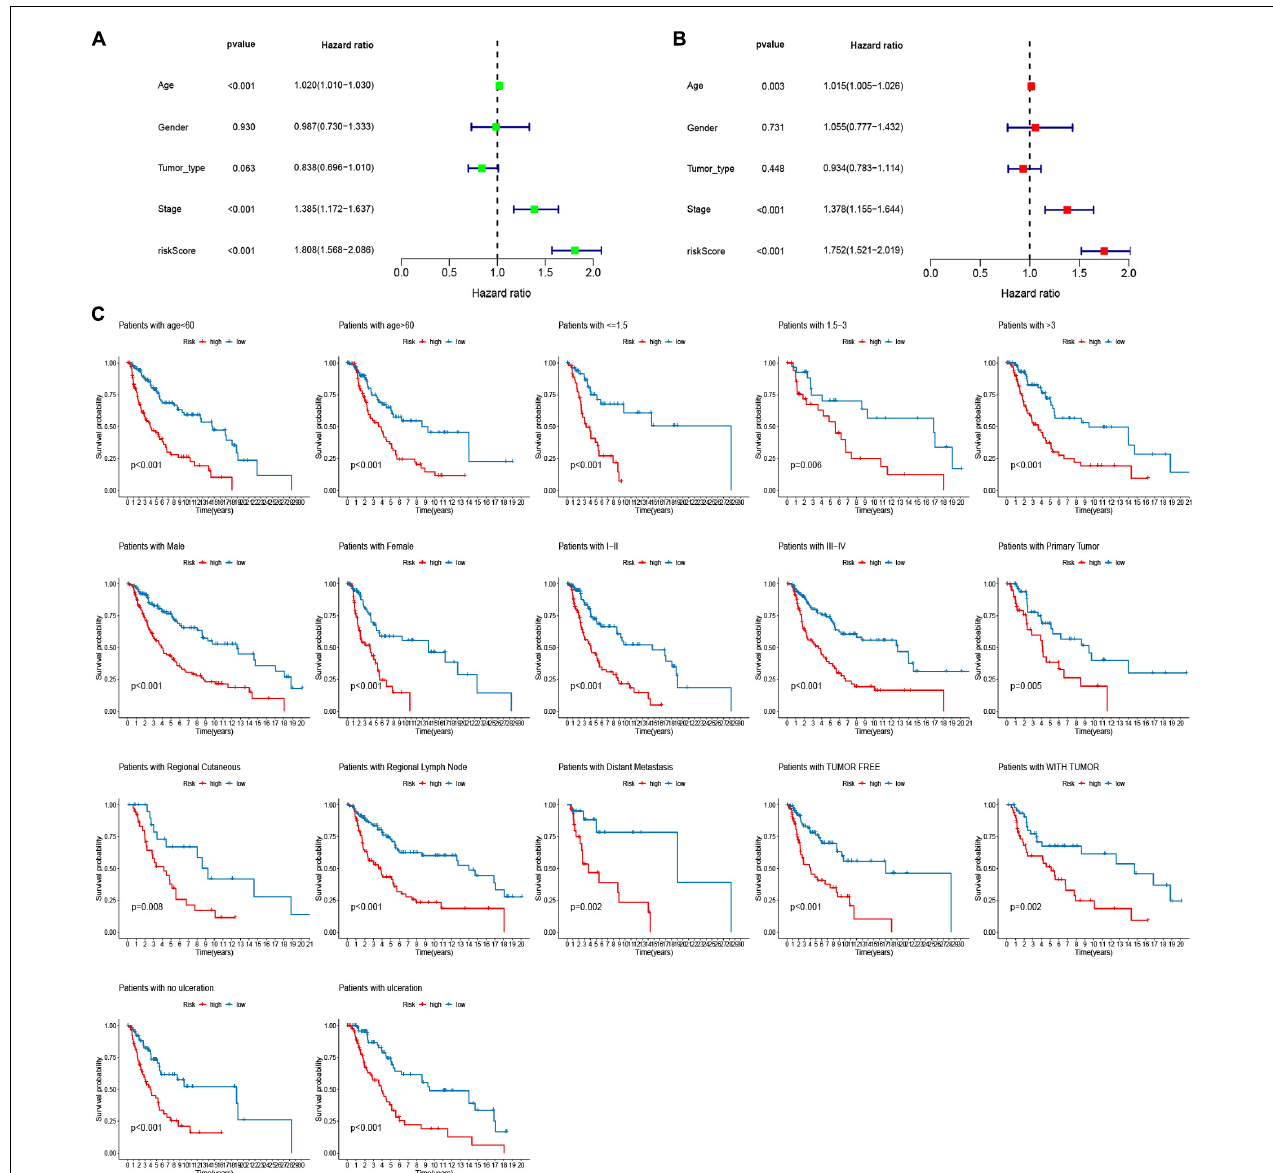
FIGURE 7 | Univariate and multivariate Cox regression analyses assessing the independent prognostic value of risk score and clinical variables. (A) Univariate Cox regression analysis. (B) Multivariate Cox regression analysis. (C) The stratification analysis assessing predictive ability of the signature in different